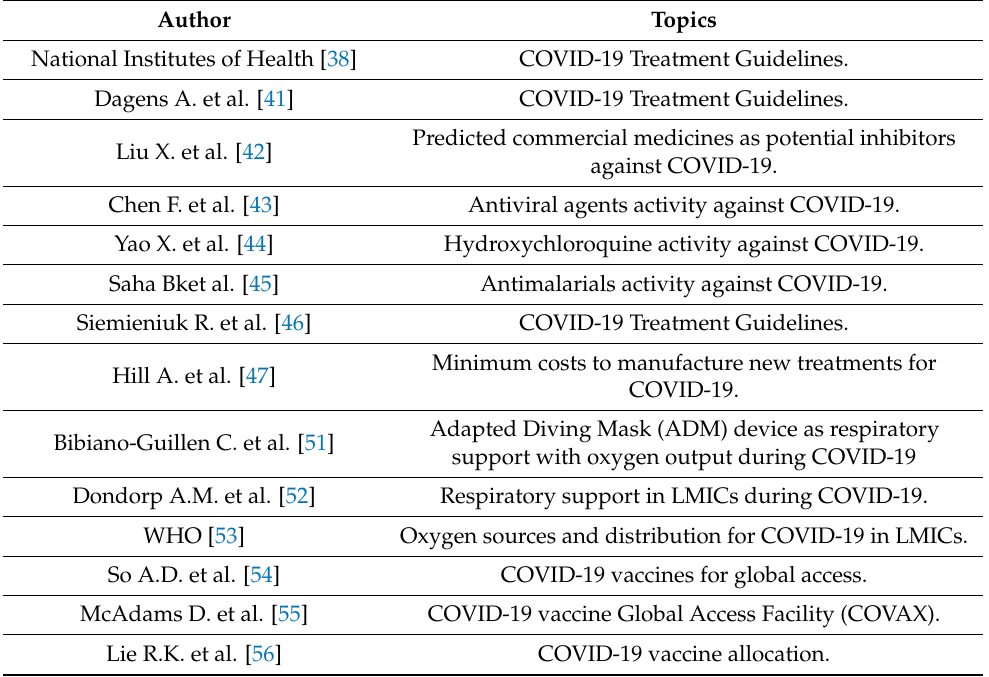
Table 2. Treatment and